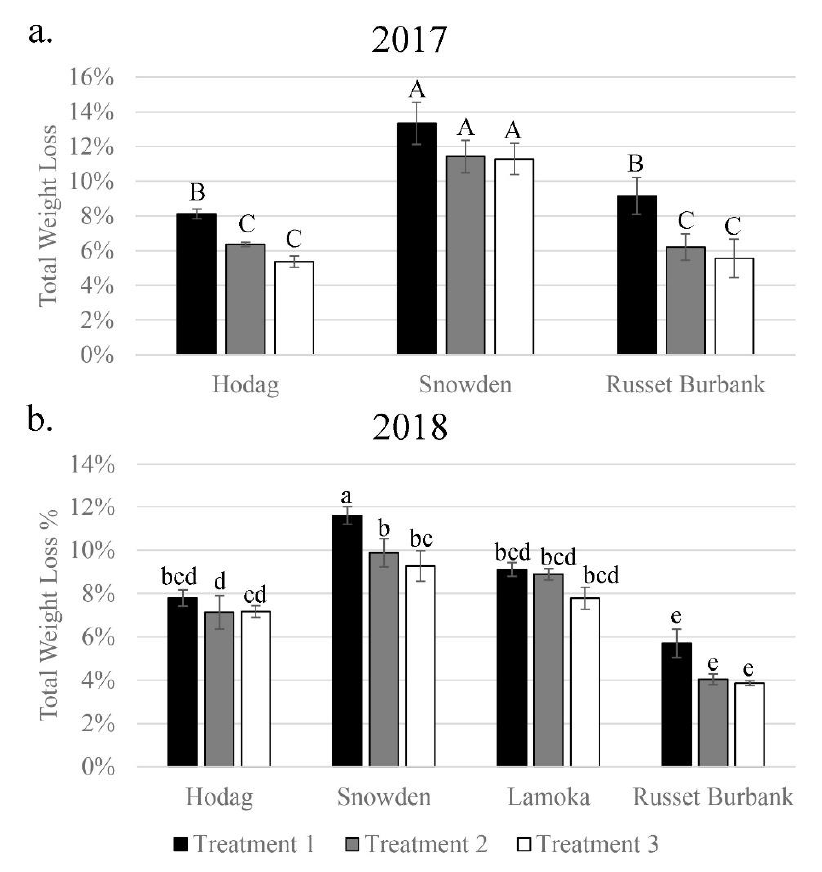
Figure 3. Total weight loss (%) of di ff erent varieties under the three wound-healing treatments in 2017 ( a ) and 2018 ( b ). In each figure, bars indicated with di ff erent letters are significantly di ff erent at α = 0.05 among di ff erent treatments and varieties.